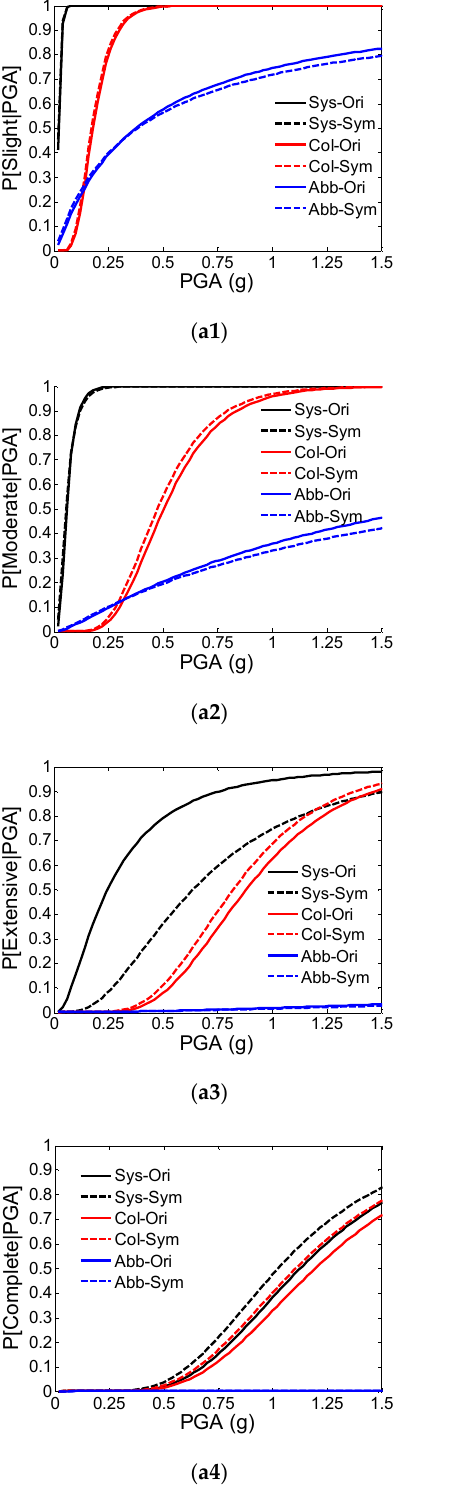
Figure 14. Seismic fragility curves of the bridge system and primary components for the original model and symmetric model:( a ) System; Column; Abb ( b ) System; Hs; HmcY; HmcZ in the ( 1 ) slight; ( 2 ) moderate; ( 3 ) extensive; and ( 4 ) complete limit states. As indicated in Figure 14a2–a4, in the moderate, extensive and complete limit states, the fragility of the column for the symmetrical model is higher than that for the